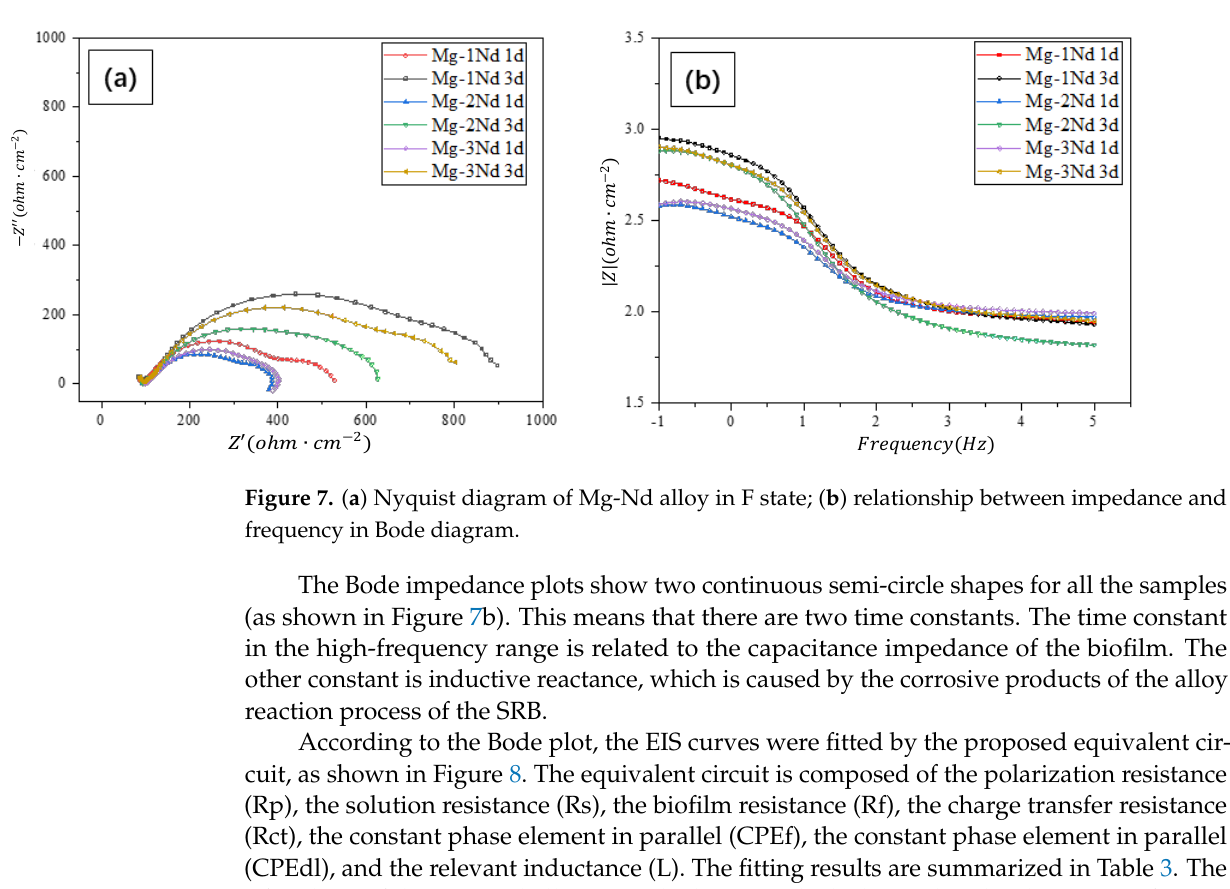
Figure 8. ( a ) Equivalent circuit diagram; ( b ) physical model of equivalent circuit.